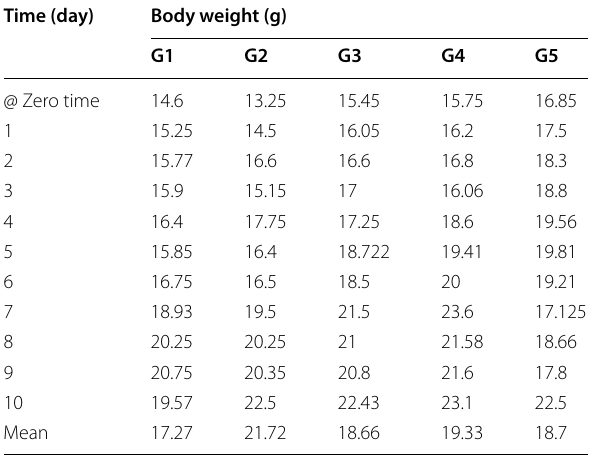
Table 3 The effect of lactobacillus cultures on body weight in experimental mice for 10 days